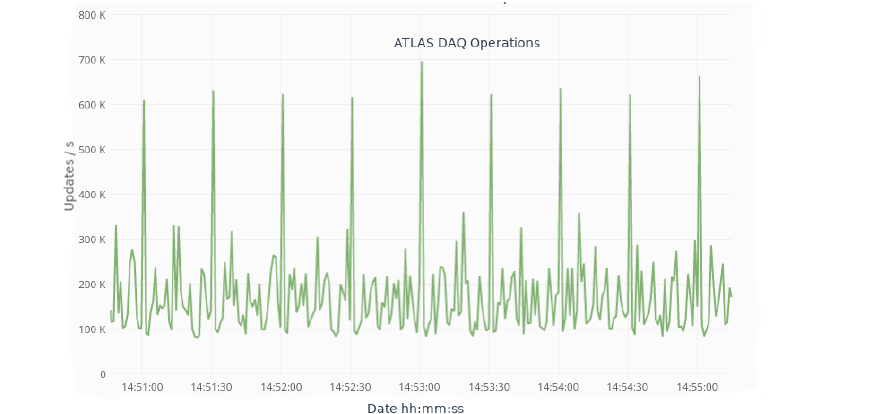
Figure 5. Rate of monitoring data updates during few minutes of a typical ATLAS data taking pe- riod [15].